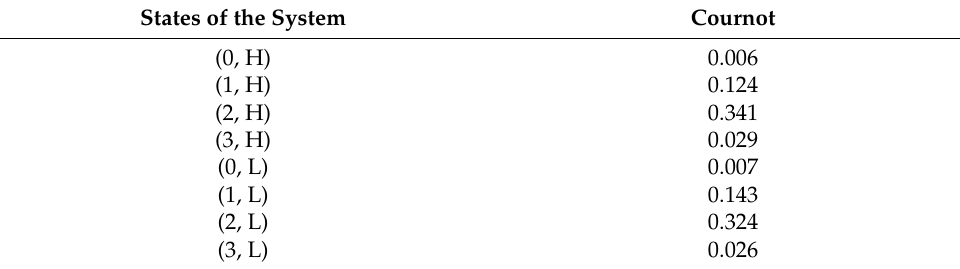
Table 17. Steady state of three active